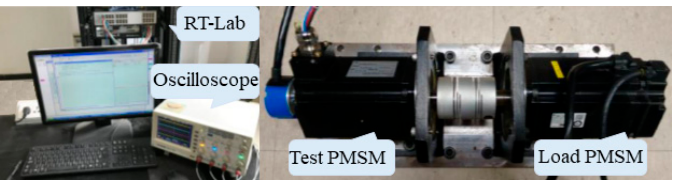
Figure 6. Test Figure 6. Test bench.